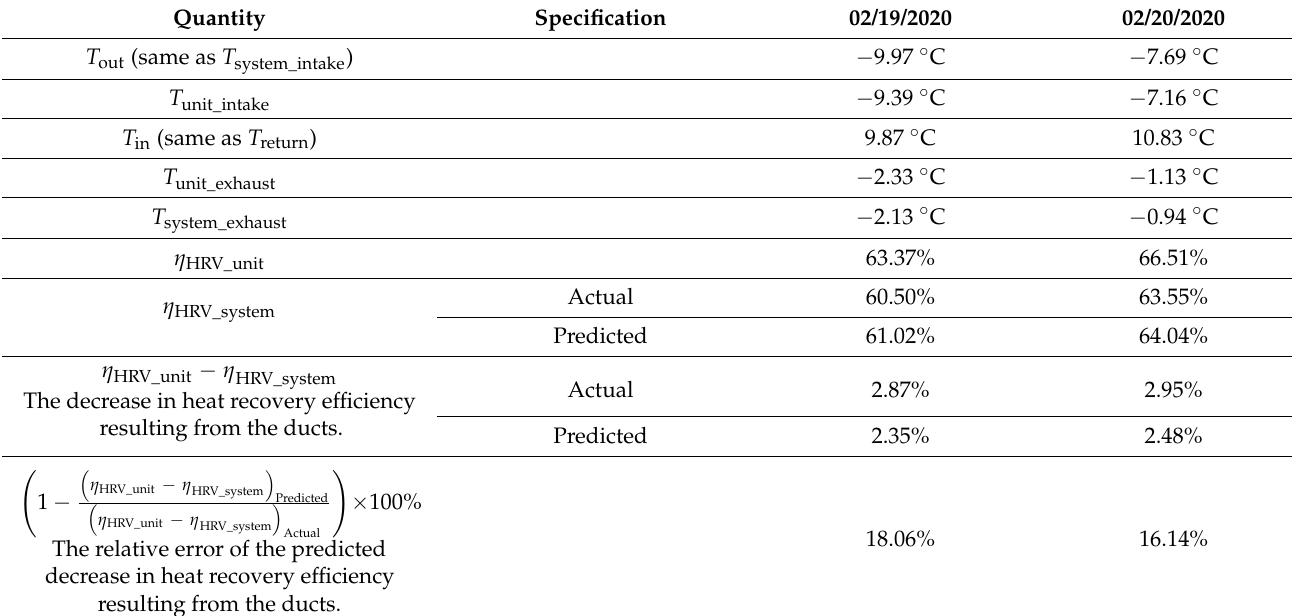
Figure 2. Overall heat recovery efficiency of an HRV system as a function of the total duct length (intake + exhaust) for different thermal insulance values. A duct inside diameter of 0.1524 m (6 in), an airflow rate of 0.02360 m 3 /s (50 ft 3 /min), and a heat recovery efficiency of the HRV unit of 70% were assumed. Table 1. Comparison between the measured and model-predicted